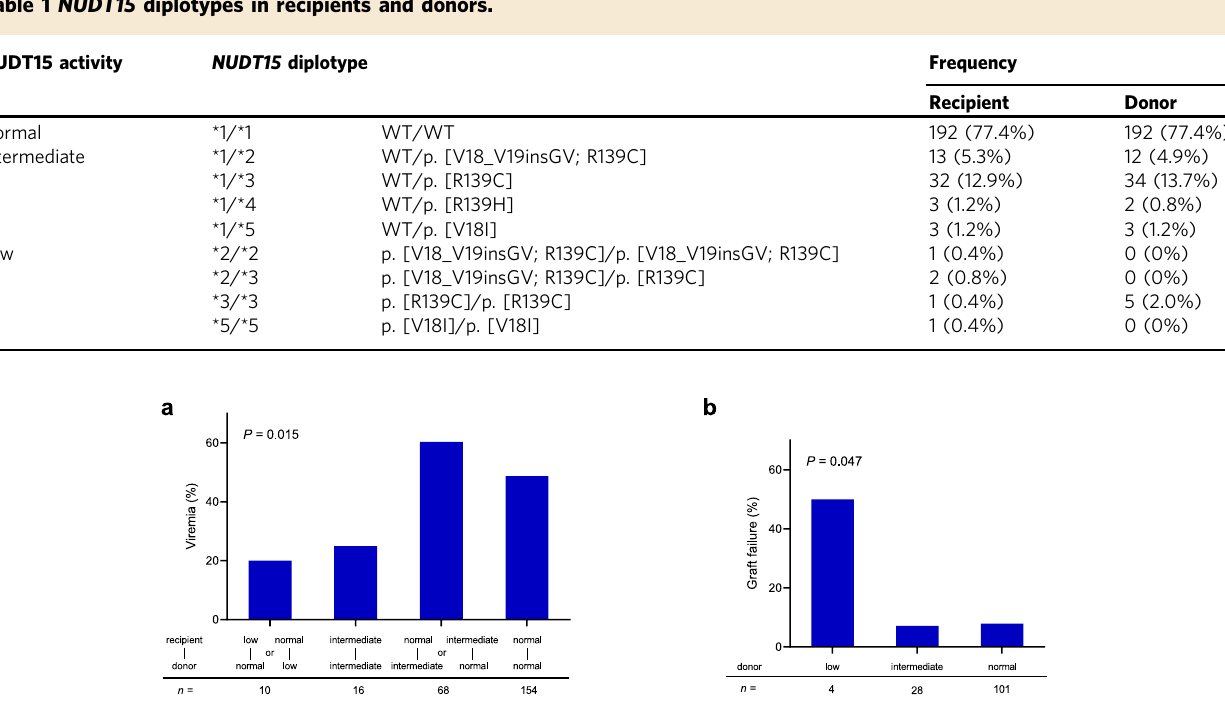
Fig. 5 Association of NUDT15 diplotypes with CMV control and graft failure in patients receiving hematopoietic stem cell transplantation. NUDT15 diplotypes (normal, intermediate, or low activity groups) in recipients and donors were classi fi ed based on the number (0: normal; 1: intermediate; 2: low) of impaired alleles (*2, *3, *4, *5) they harbored. a Incidence of CMV viremia in recipients on acyclovir prophylaxis was plotted by the combinations of NUDT15 diplotype of recipient and donor as follows: low/normal or normal/low; intermediate/intermediate; normal/intermediate or intermediate/normal; normal/normal. There were no patients with other combinations in our study cohort. P value (two-sided) was calculated using a Chi-square test. b The rate of graft failure in recipients who had CMV-seropositive donors was plotted by the NUDT15 diplotype of donors. P value (two-sided) was calculated using a Fisher ’ s exact test. Source data for a and b are provided as a Source Data fi